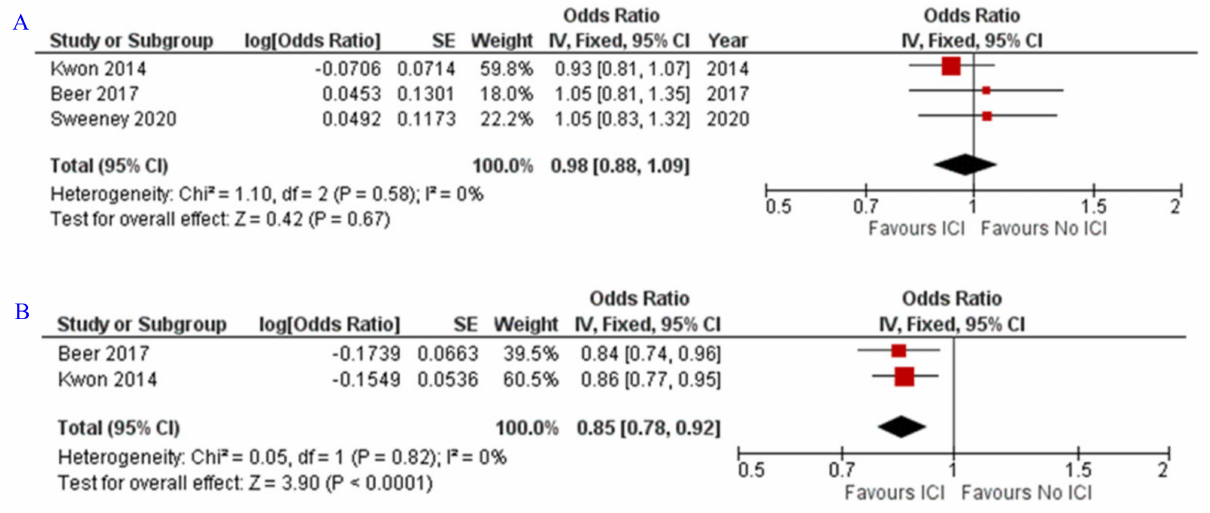
Figure 3. Forest plot for the impact of ICIs, on the ( A ) OS and ( B ) PFS. ICIs, immune checkpoint inhibitors; OS, overall survival; PFS, progression-free survival. Sweeney et al., 2020 [25], Kwon et al., 2014 [24], Beer et al., 2017